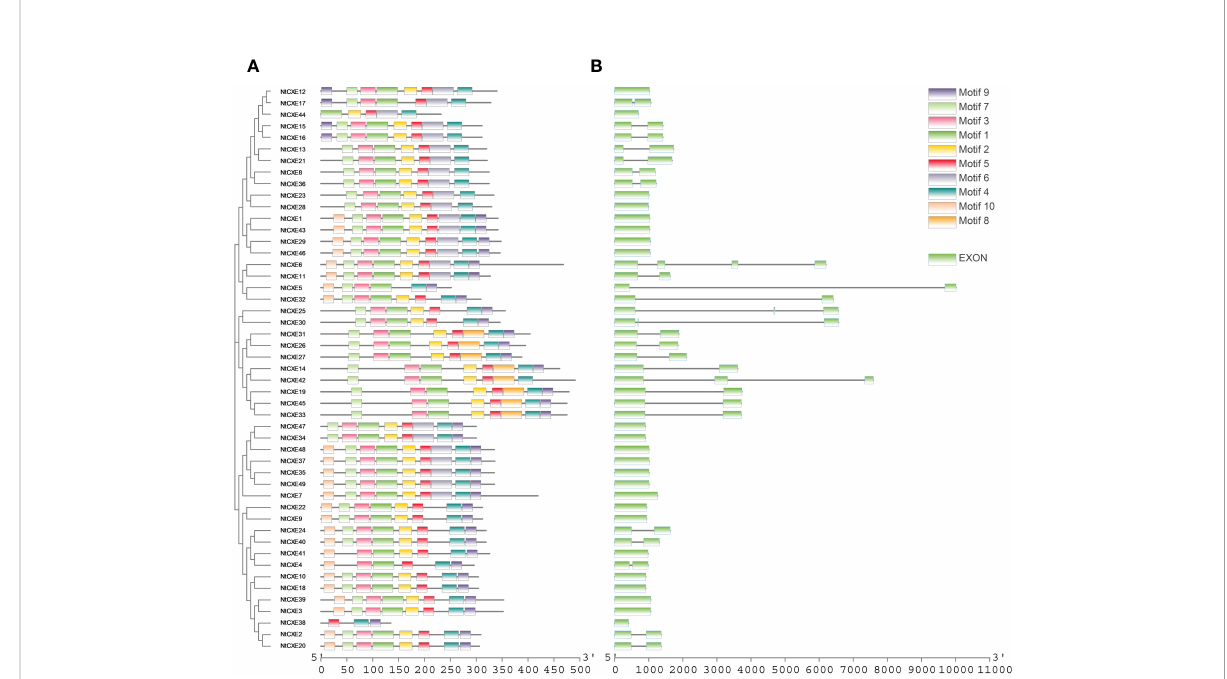
FIGURE 3 Phylogenetic relationship, gene structures, and protein conserved motif of NtCXE genes. (A) Analysis of conserved motif in the amino acid sequences of NtCXEs. The differently colored boxes in the upper right corner represent different conserved motifs with the number 1 to 10. The sequence information corresponding to different motifs is provided in Supplementary Table 5. (B) Exon-intron structure of NtCXEs in